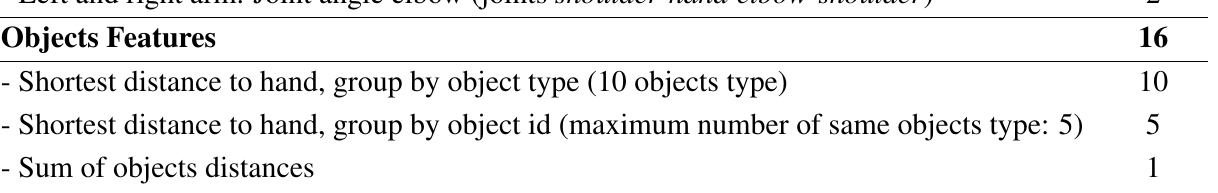
Table 1. Summary of the features vector used for the dynamic time warping (DTW) algorithm. Description Count Skeleton